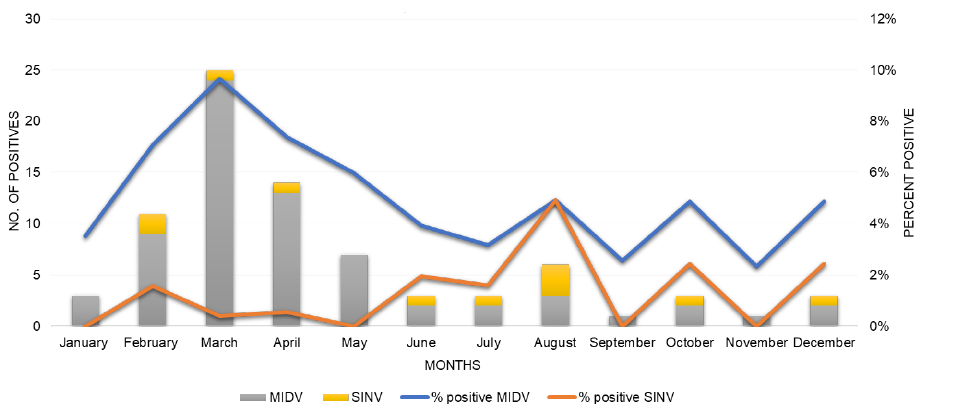
Figure 1. Seasonal detection of Middelburg virus (MIDV) ( n = 69) and Sindbis virus (SINV) ( n = 11) positive infections in horses from South Africa between January 2014–December 2018. Number of MIDV positives indicated by grey bars and percent positivity indicated by blue line. Number of SINV positives indicated by yellow bars and percent positivity indicated by orange line. Samples were received from all nine provinces within South Africa with MIDV in- fection detected in all provinces except Limpopo. The highest percent positives for MIDV were detected from the Free State (16.66%; 8/48), Mpumalanga (11.76%; 4/34), KwaZulu Natal (9.23%; 12/130), North West (8.10%; 3/37) and Gauteng (7.07%, 30/424). SINV posi- tives were detected from Eastern Cape (3.12%; 2/64), Northern Cape (2.00%; 1/50), Kwa- Zulu Natal (1.53%; 2/130), Gauteng (0.94%; 4/424) and Western Cape (0.83%; 2/239) prov- inces only (Figure 2).